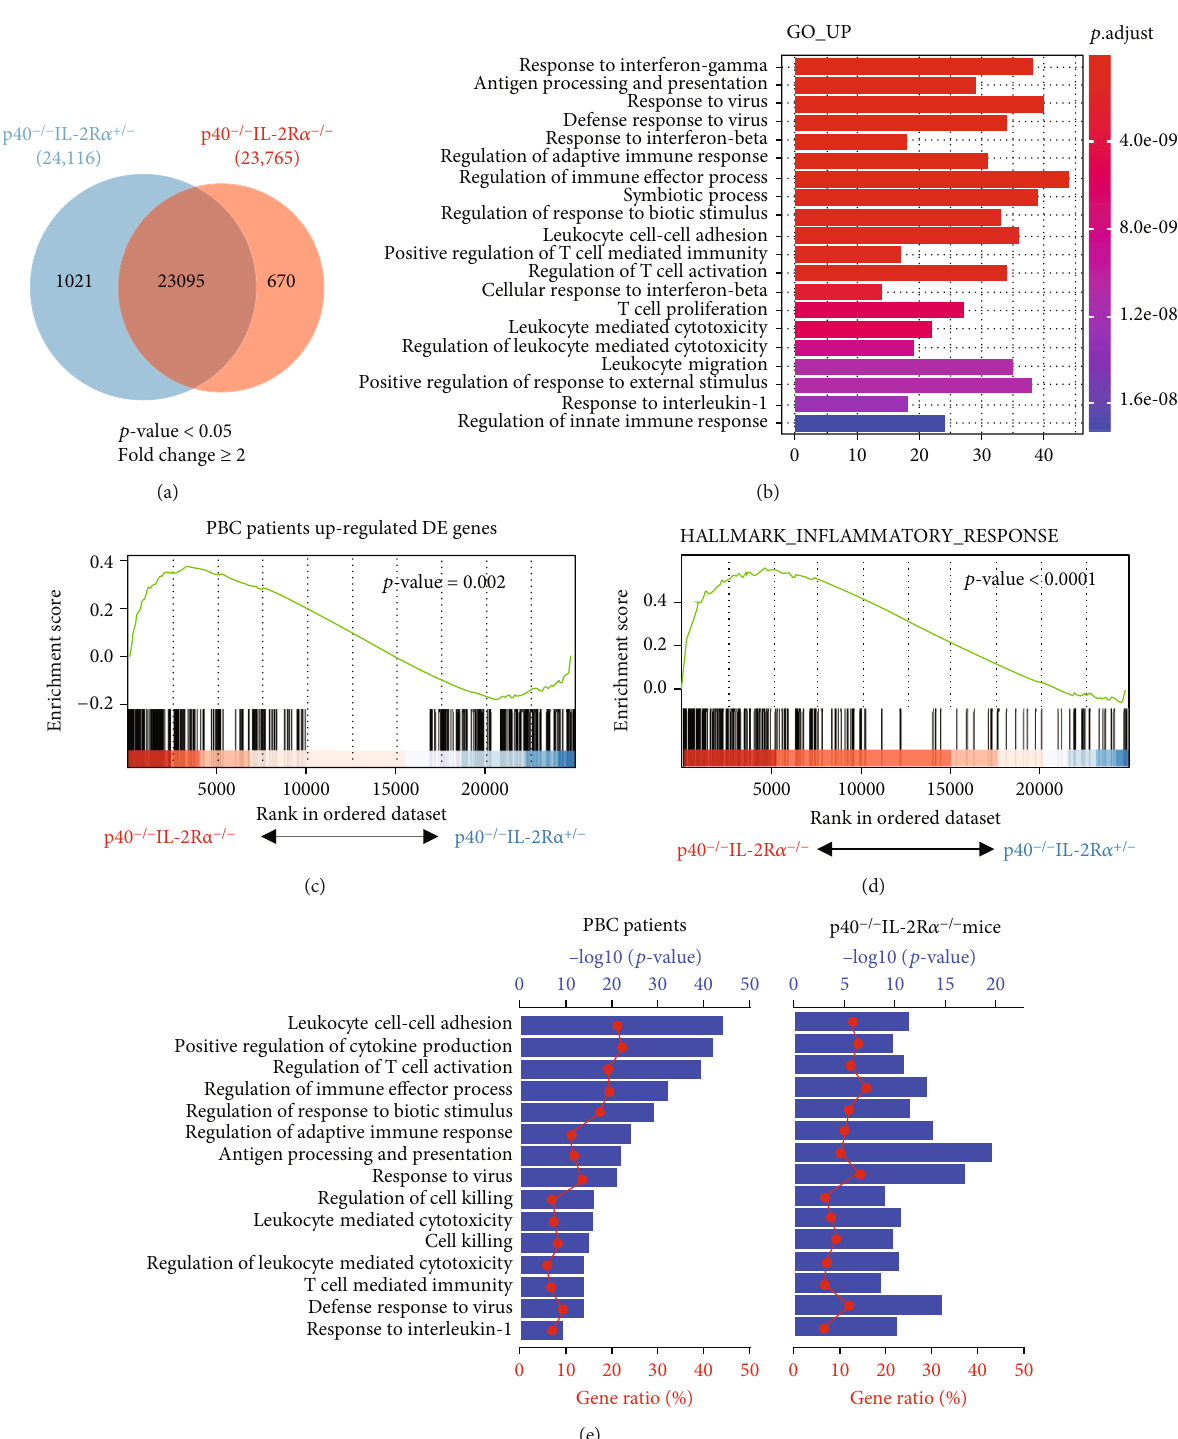
Figure 1: Hepatic gene expression in p40 -/- IL-2Ra -/- and control mice. (a) Venn diagram of DEGs in livers from p40 -/- IL-2Ra -/- ( n = 3 ) and p40 -/- IL-2Ra +/- ( n = 3 ) mice. (b) GO analysis showing top 20 enriched biological functional pathways of upregulated genes in livers from p40 -/- IL-2Ra -/- mice. (c, d) GSEA for p40 -/- IL-2Ra -/- mouse DEGs using gene sets of human PBC DEGs (c) and hallmarks of in fl ammatory response (d). (e) Canonical enriched pathways of human PBC with p40 -/- IL-2Ra -/- mice. In one pathway, the ratio of genes captured in this gene set (from PBC patients or p40 -/- IL-2R α -/- mice) to the total number of genes contained in this pathway in the GO ” of the p value (blue bar, top axis) was obtained by Fisher ’ s database is indicated by “ gene ratio ” (red line, bottom axis). The “ -Log 10 exact